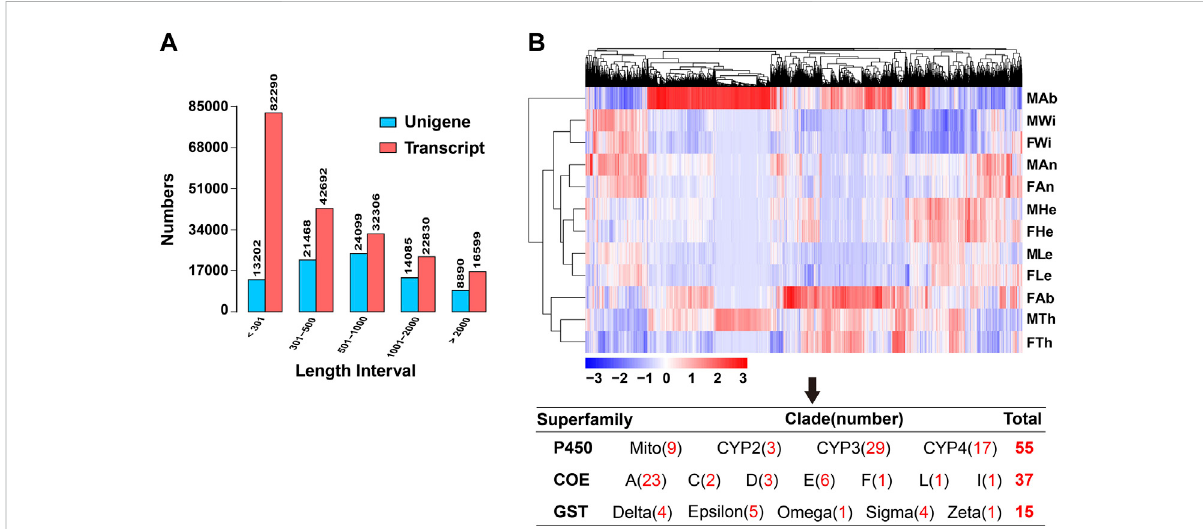
reference transcriptome (i.e., the unigene transcriptome), with a